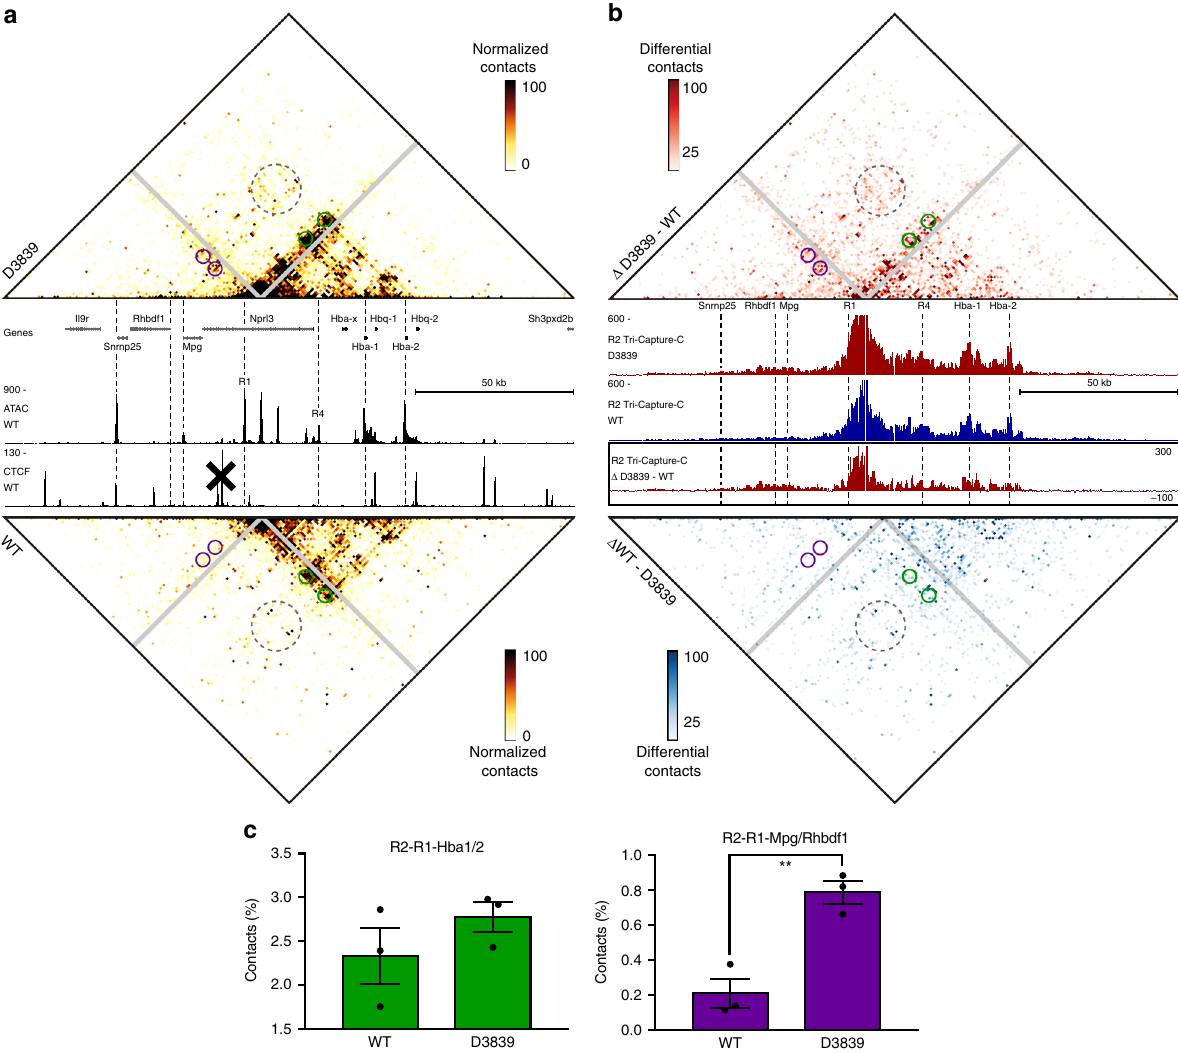
Fig. 2 The formation of the enhancer – promoter hub at the α -globin locus is not dependent on the upstream CTCF boundary. a Tri-C contact matrices showing multi-way chromatin interactions with R2 in D3839 (top) and WT (bottom) erythroid cells. Matrices represent mean numbers of normalized, unique contact counts at 1kb resolution in n = 3 biological replicates with proximity contacts around the R2 viewpoint excluded (gray diagonal). Gene annotation, open chromatin (ATAC) and CTCF occupancy in WT erythroid cells are shown in the middle. Coordinates (mm9): chr11:32,070,000 – 32,250,000. b Tri-C contact matrices showing differential multi-way chromatin interactions with R2 between D3839 and WT erythroid cells (top) and vice versa (bottom). Pair-wise interaction pro fi les derived from the Tri-C data from the R2 viewpoint (R2 Tri-Capture-C) are shown in the middle (D3839 in red, WT in blue), with a differential pro fi le in the bottom panel. Coordinates (mm9): chr11:32,070,000 – 32,250,000. c Quanti fi cation of multi-way contacts between R2, R1, and the α - globin promoters (R2 – R1 – Hba1/2 , green, P = 0.29) and R2, R1, and the Mpg and Rhbdf1 promoters (R2 – R1 – Mpg / Rhbdf1 , purple, P = 0.0055). Quanti fi ed contacts are highlighted with corresponding colors in the matrices above. Numbers represent the proportion of these three-way contacts relative to the total in the matrix and are averages of n = 3 biological replicates, with individual data points overlaid as dot plots and the standard error of the mean denoted by the error bar. P -values were calculated by two-tailed t